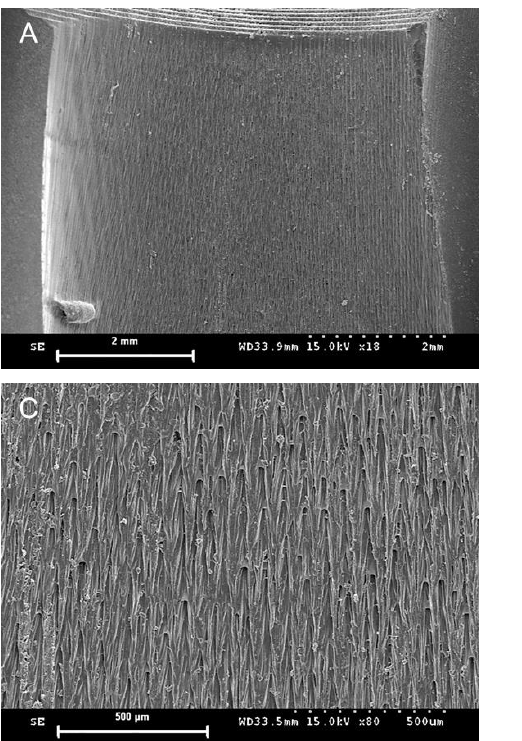
Figure 5. Preoperative and postoperative angular deviations of the MSF and MSI groups. The lines inside the boxes indicate median values, and the cross signs inside the boxes indicate mean values. The borders of the boxes indicate the 25th and 75th percentiles. The whiskers indicate the minimum and maximum values. The statistically significant difference is marked with an asterisk ( p < 0.05). BL, buccolingual. MD, mesiodistal.